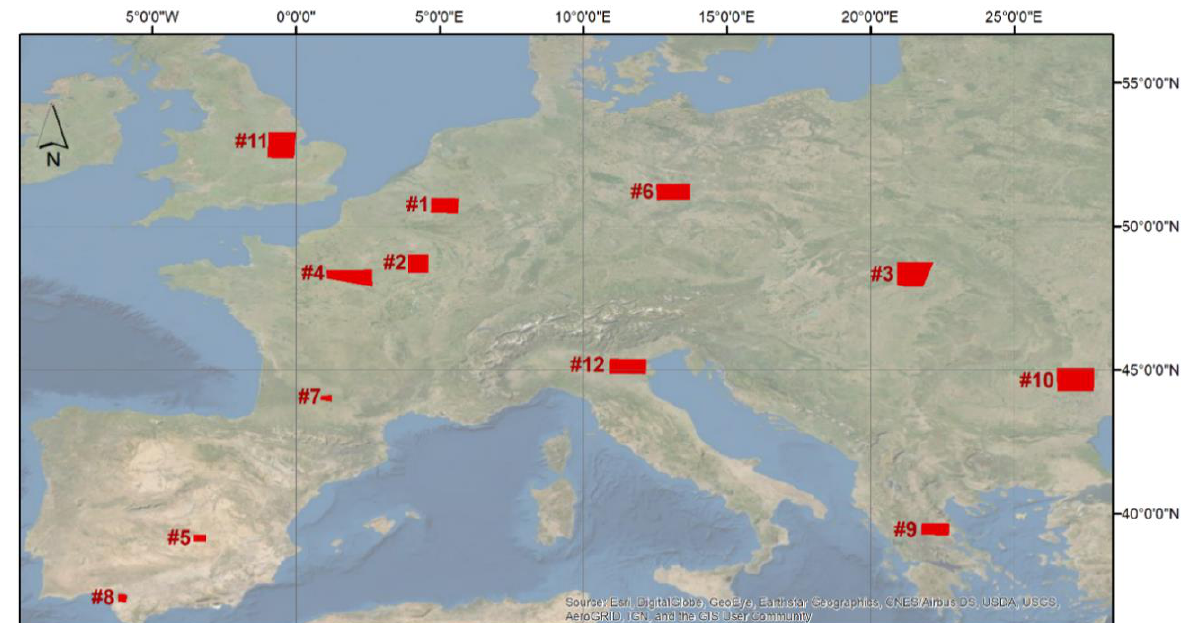
Figure 7. Spatial distribution of the L8 subsets areas used for the validation of the SaSbEM. The reference system of the image is WGS 84 (EPSG: 4326).